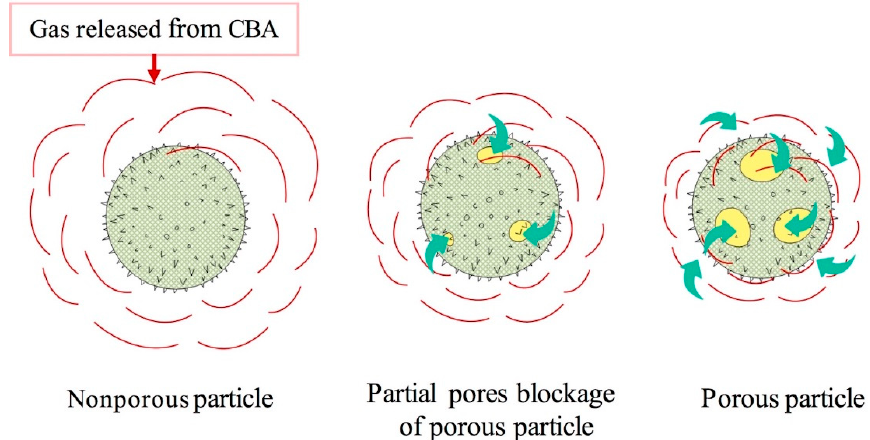
Figure 8. Schematic representation of the porous and nonporous nucleating agent mechanism of zeolite during foaming.